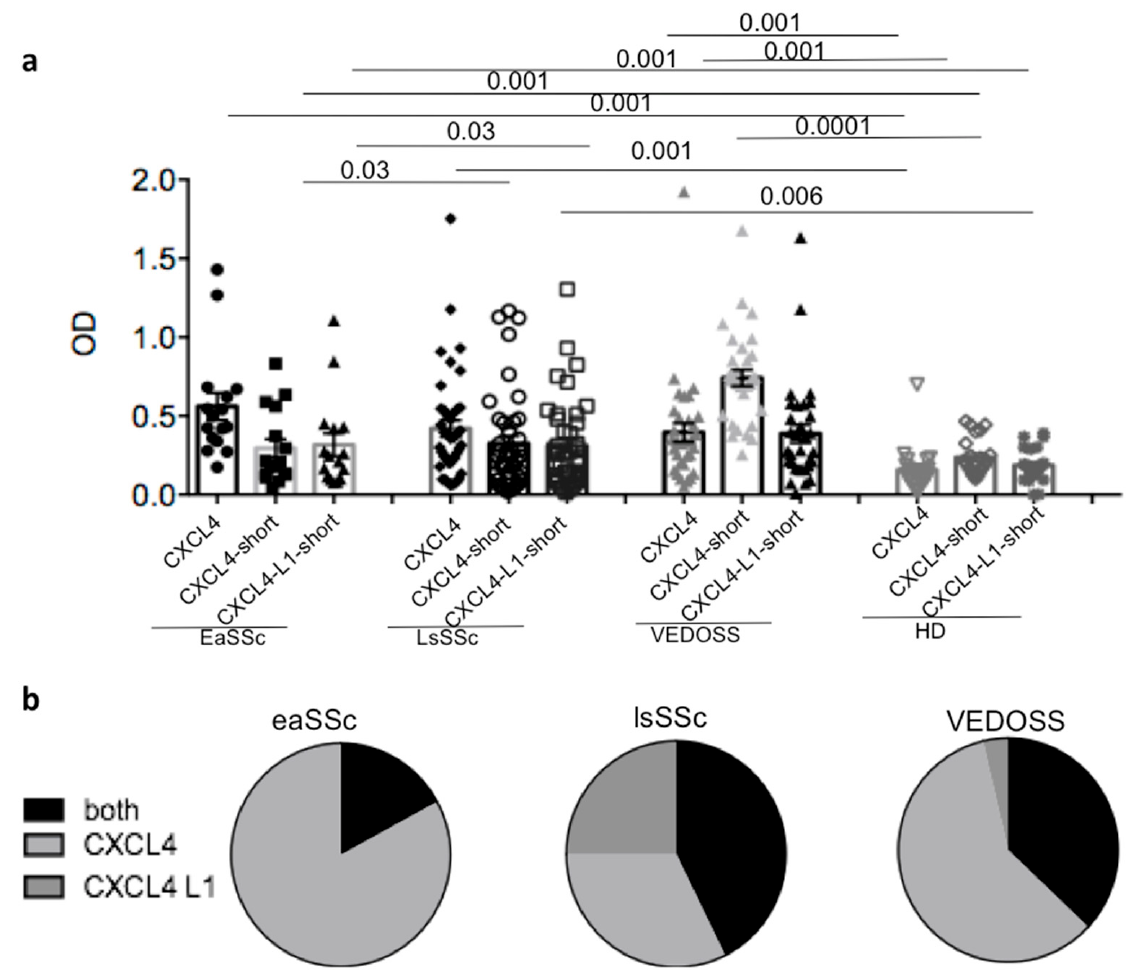
Figure 1. Systemic Sclerosis (SSc) and Very Early Diagnosis of Systemic Sclerosis (VEDOSS) share autoantibody specificity. ( a ) SSc (early SSc (eaSSc) and long-standing SSc (lsSSc)), control healthy donors (HD) and VEDOSS patients were tested for serum or plasma antibody reactivity to entire Chemokine (C-X-C motif) ligand 4 (CXCL4) (CXCL4) or to the 27 mer peptides spanning the COOH-term of CXCL4 (CXCL4-short) or CXCL4-L1 (CXCL4-L1-short), by ELISA. Results are reported as optical density (OD). Horizontal bars represent the mean; vertical bars are standard error of the mean (SEM); p values by Mann–Whitney test. Cut-off lines for anti-CXCL4 (continuous black line), for CXCL4-COOH (dotted gray line) and for anti-CXCL4-L1 (dotted black line) antibodies are reported on the graph. ( b ) Anti-CXCL4 and anti-CXCL4-L1 antibody reactivity distribution in SSc and VEDOSS, represented as cake diagrams. In the diagrams, the reactivity to one or the other CXCL4 form is reported as percent of reactivity (entire diagram represents 100% of the clinical samples tested).